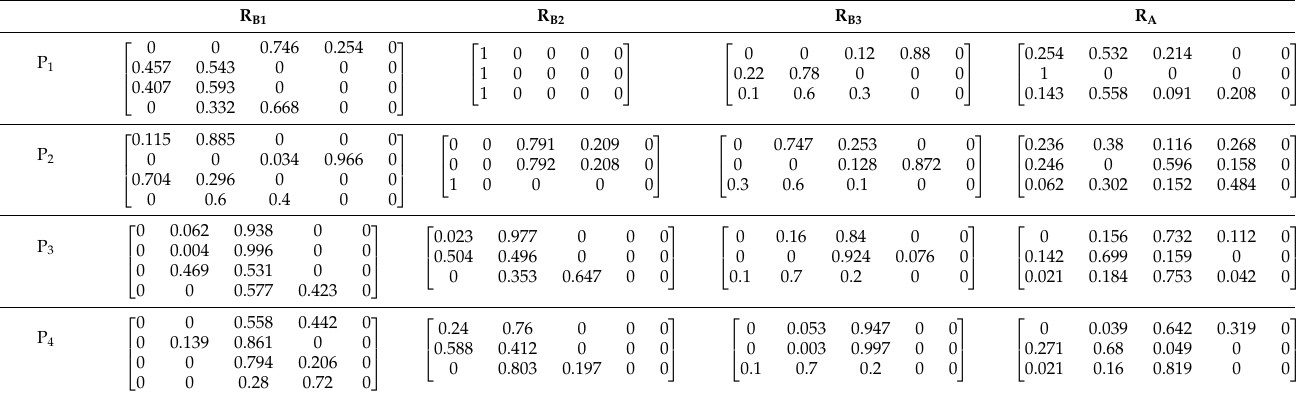
Table 4. Fuzzy relationship matrix of the quantitative